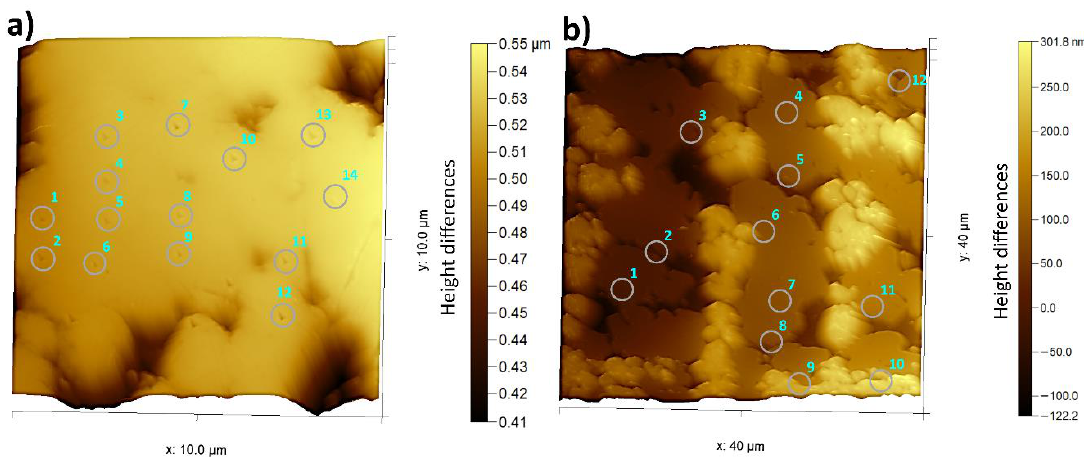
Figure 6. 3D topography image with assigned tip places for the dendritic-like phase ( a ) and for the “light-grey” phase ( b ).